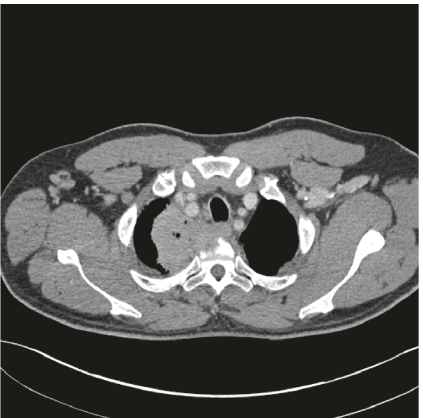
Figure 1: Computed tomography scan of the chest showing right superior sulcus mass invading a vertebral body.